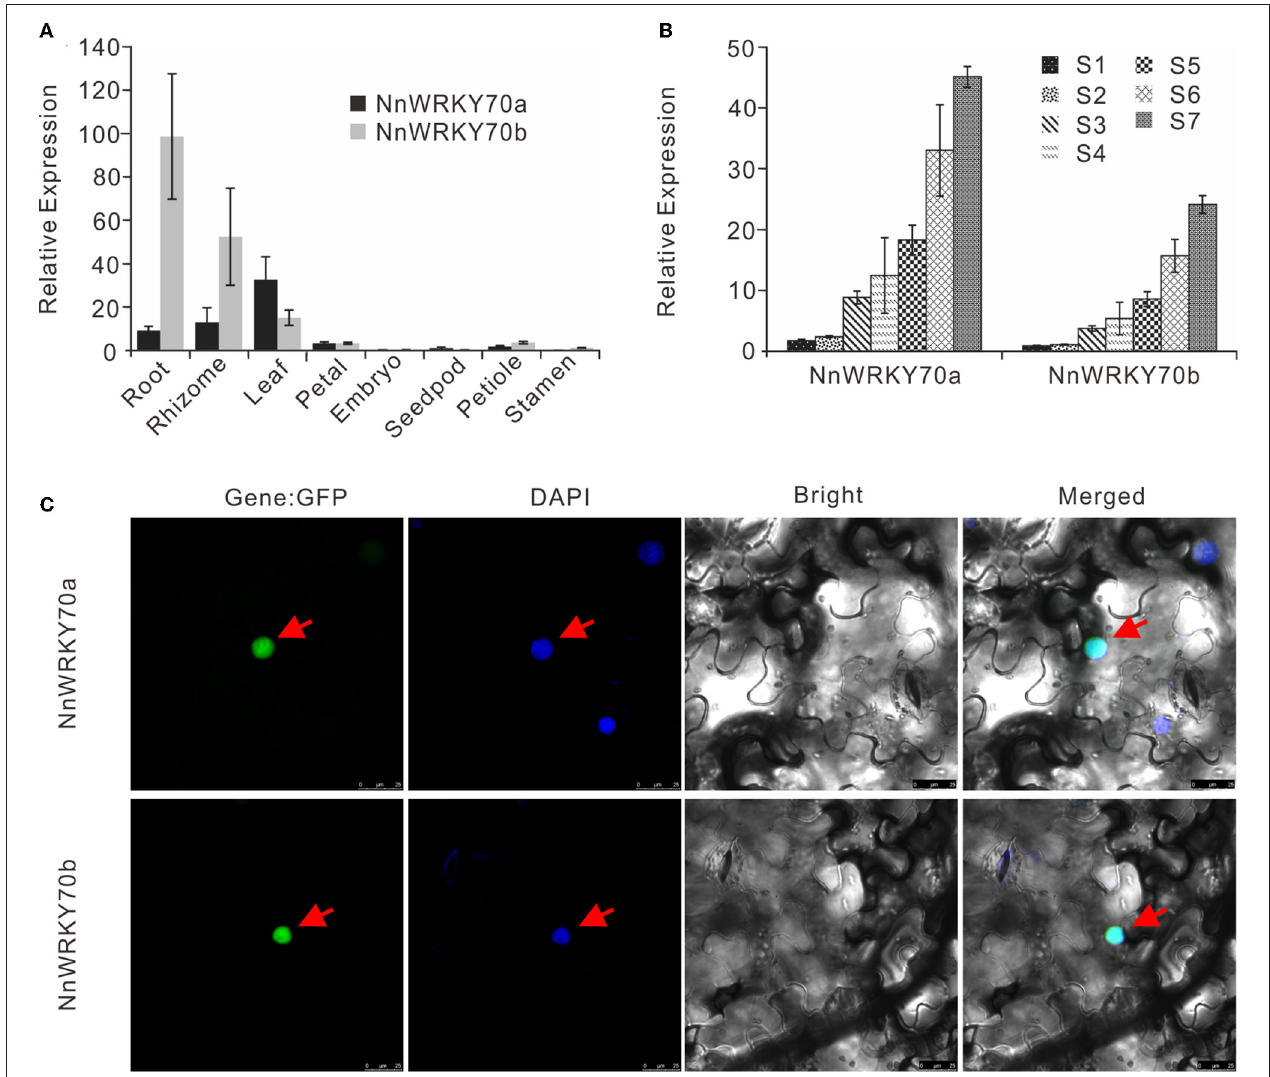
FIGURE 3 | Expression profiling and subcellular localization of NnWRKY70s. (A) Spatial expression profiling of NnWRKY70 s in different lotus organs. (B) Temporal expression profiling of NnWRKY70 s in seven developmental stages of lotus leaf (S1–S7). Data of (A,B) are mean ± SE ( n = 3). (C) Subcellular localization of NnWRKY70a and NnWRKY70b in N. benthamiana leaves. Panels from left to right refer to GFP, DAPI, bright, and merged images, respectively. Protein fusions co-localized with DAPI markers are marked with red